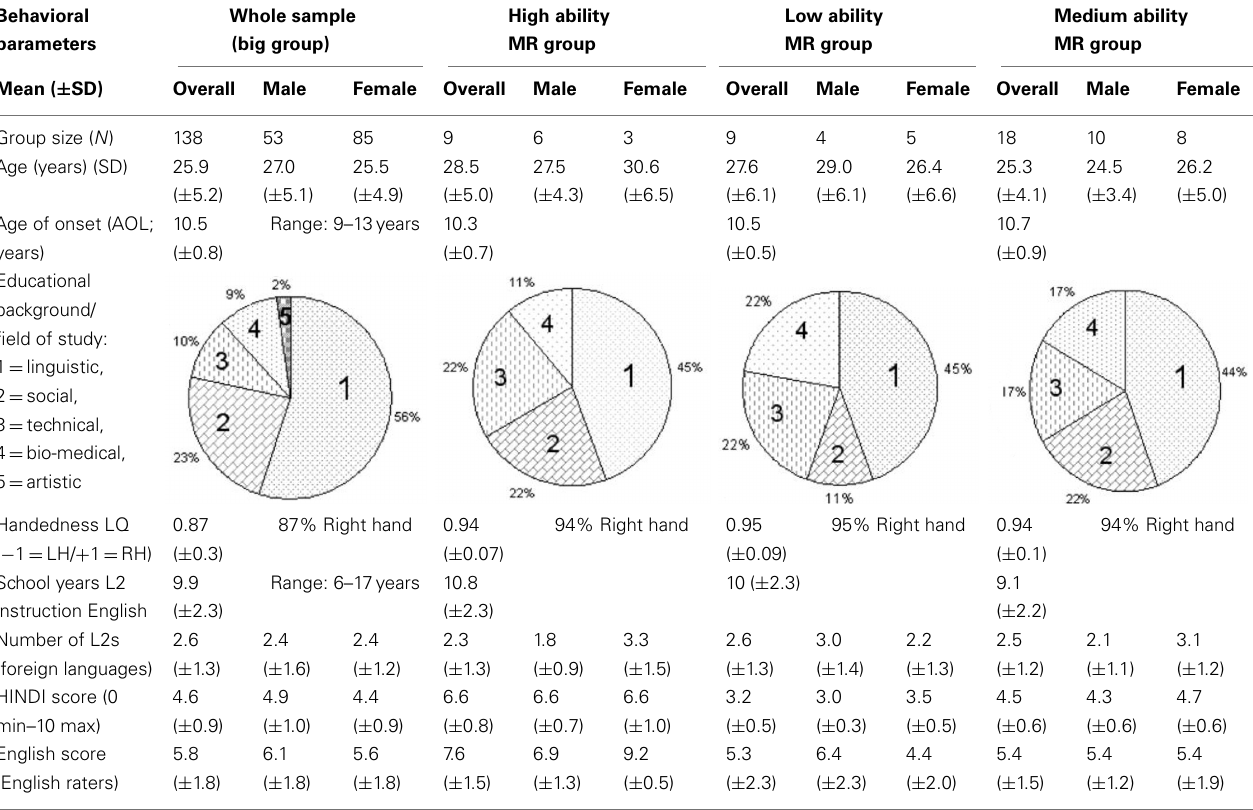
Table 1 | Behavioral parameters of the participant groups in the different